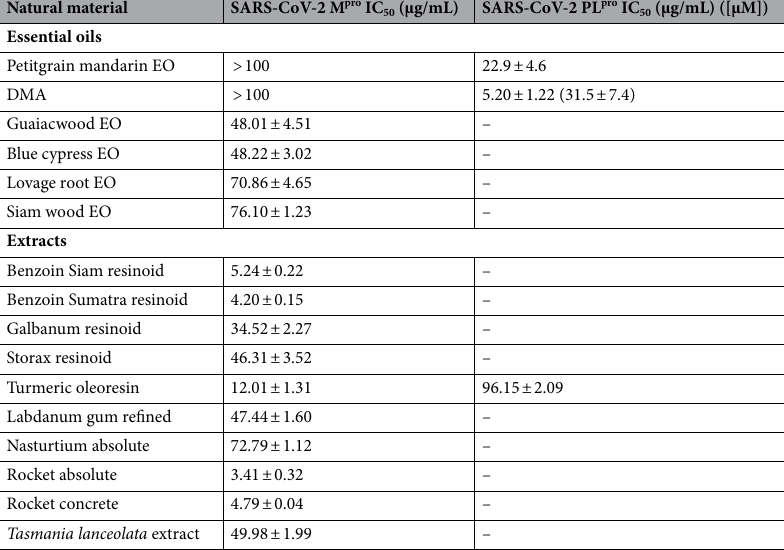
Table 4. Inhibition parameters of essential oils and aromatic extracts and SARS-CoV-2 M pro and PL pro .